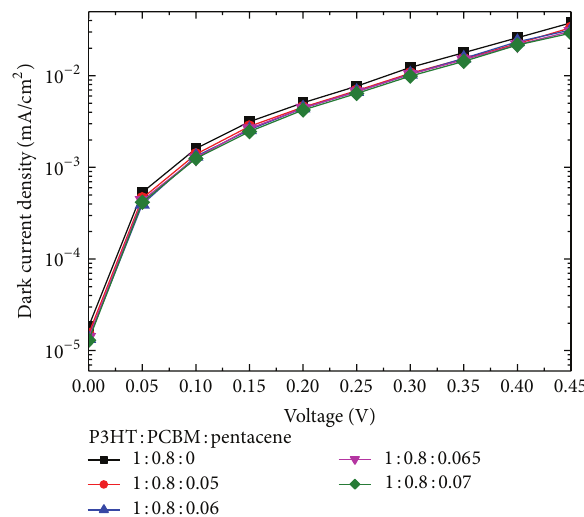
Figure 10: Dark current density-voltage characteristics of the inverted PSCs with various pentacene-doped absorption